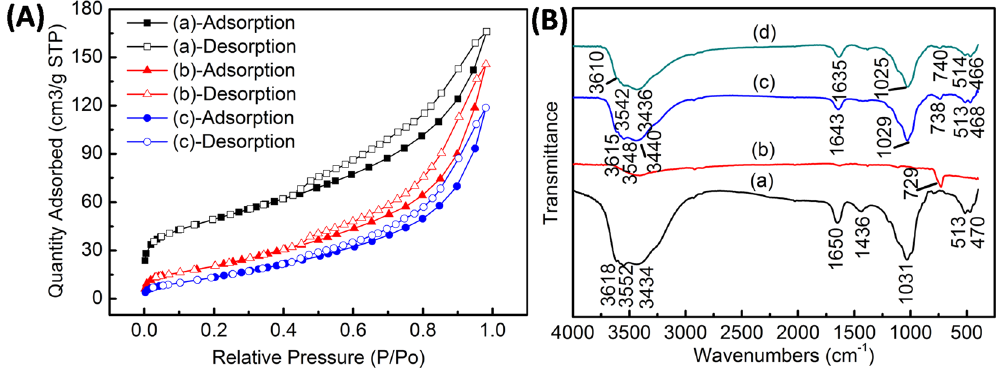
Figure 5. ( A ) Nitrogen adsorption–desorption isotherm of (a) raw attapulgite, (b) Sb 2 Se 3 -Sb 2 O 3 -attapulgite and (c) Sb 2 Se 3 /Sb 2 O 3 @attapulgite; ( B ) FTIR spectra of the samples: (a) raw attapulgite, (b) Sb 2 Se 3 sample, (c) Sb 2 Se 3 - Sb 2 O 3 -attapulgite and (d) Sb 2 Se 3 /Sb 2 O 3 @attapulgite.